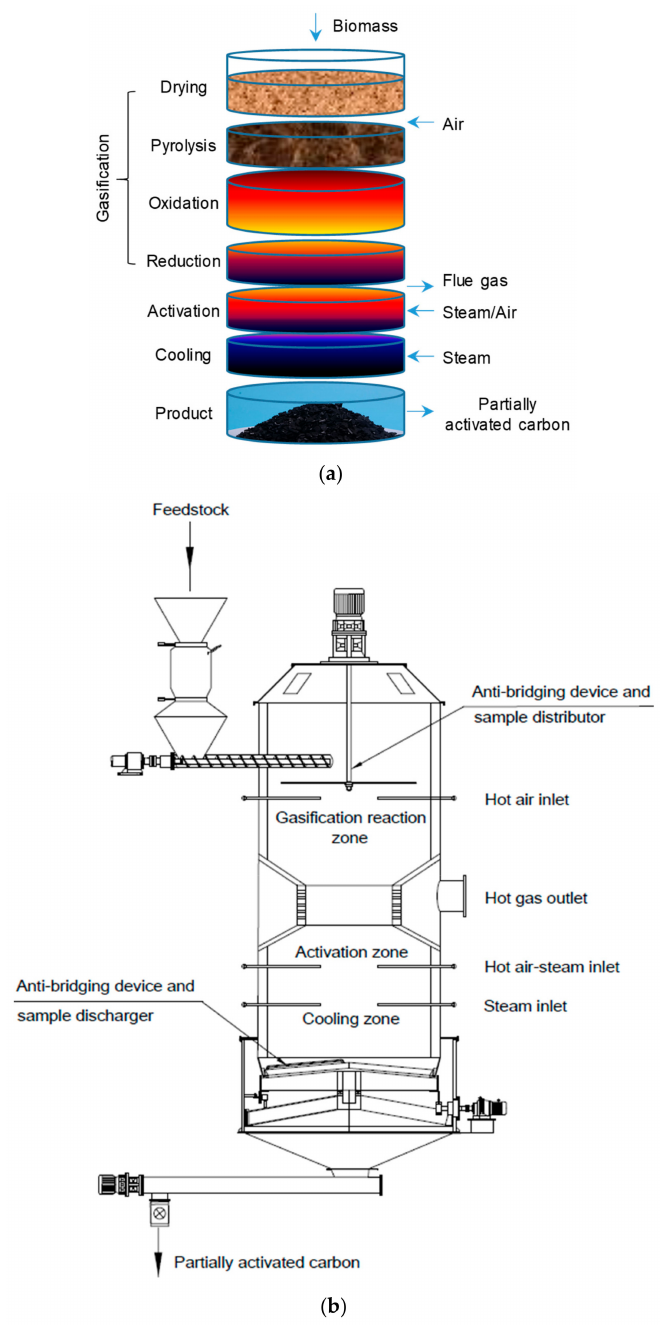
Figure 2. The conceptual illustration ( a ) and the structure ( b ) of the commercialized gasification